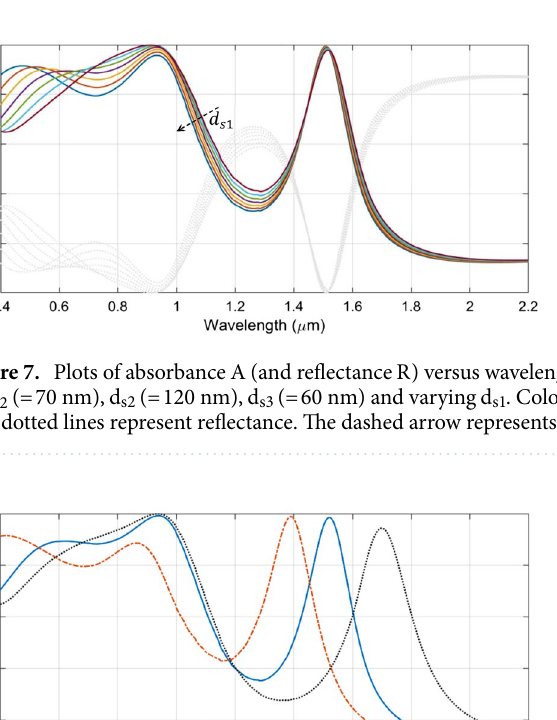
90 nm, d s2 120 nm, and d s3 = = d s2 d s3 120 nm; the dotted black line represents the case of = = =